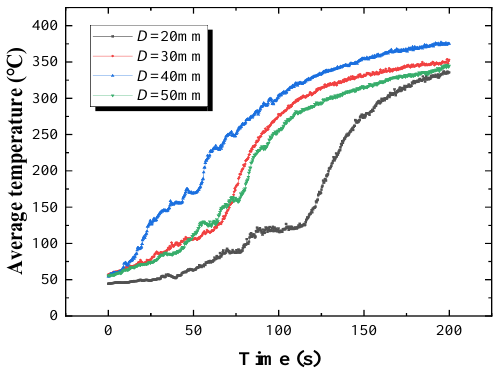
ff erent overlap